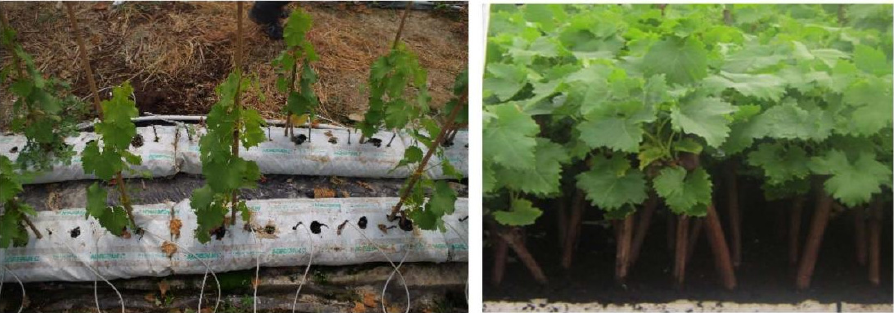
Figure 7. Table-grape hardwood cuttings ready to the successive phase of training in the greenhouse: in plastic bags ( left ); in alveolar tray ( right ).